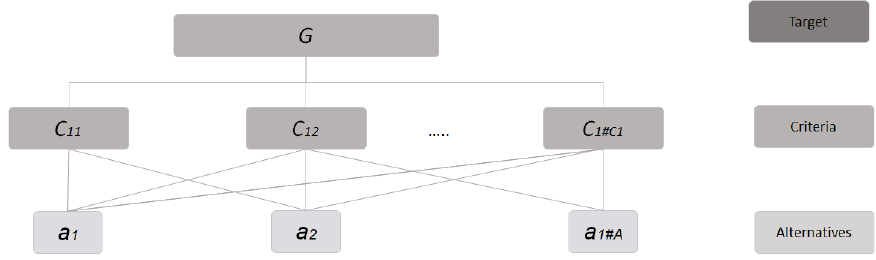
Figure 2. Hierarchic System of Problem.